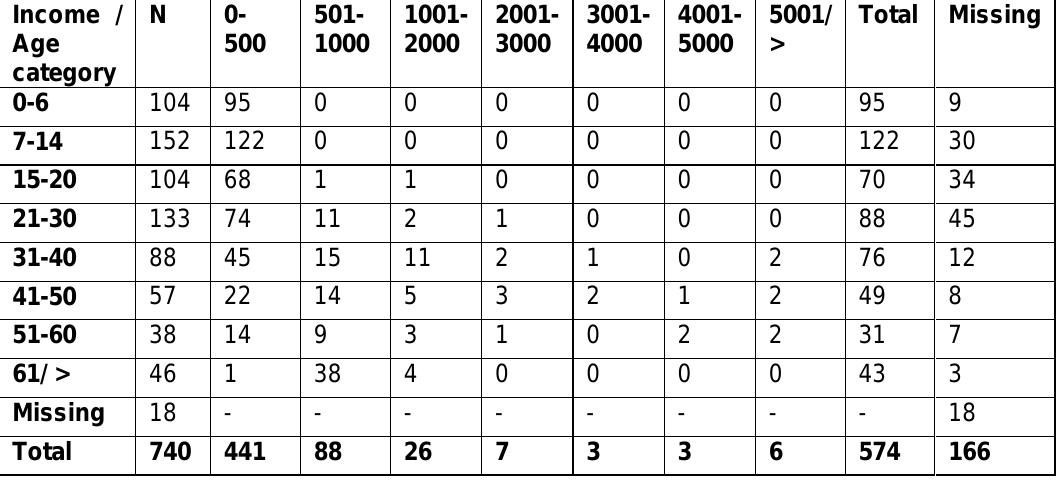
Table 4: Distribution of income per age category per month in 2007 Income